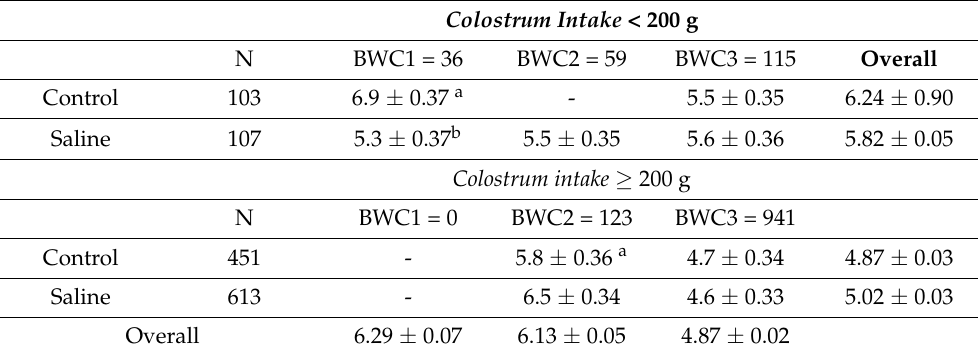
Table 2. Mean ± SE for suckling weight gain (kg) from 24 h to 20 d in 1274 piglet observations after bootstrapping at a root of 24. Body weight category: BWC1; ≤ 0.80 kg, BWC2; 0.81 kg to 1.10 kg, and BWC3; >1.10 kg. Saline = intraperitoneal 45 ◦ C saline injection. N = number of piglets per group.